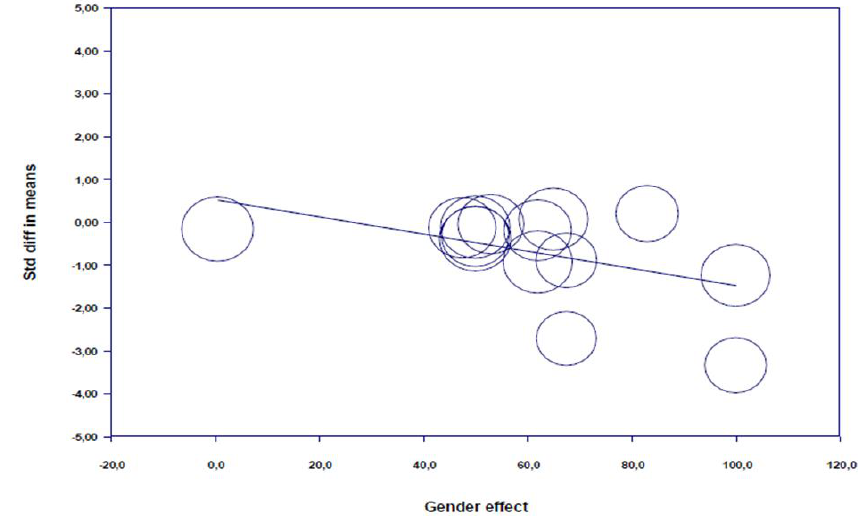
Figure 3. Scatter plot of regression analysis showing the influence of polyphenols supplementation by gender.